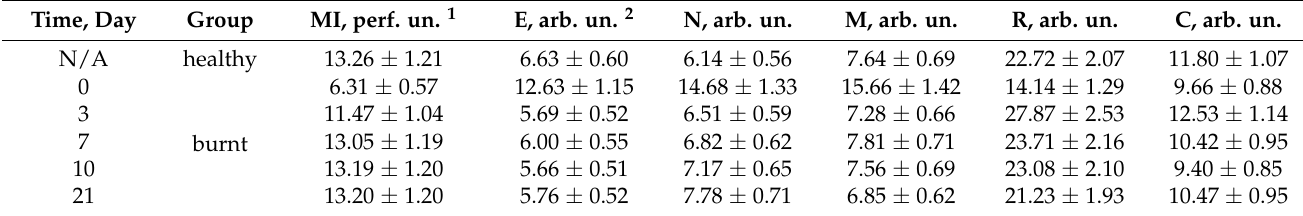
Table 10. Results of Doppler flowmetry of blood microcirculation in a burn wound under the action of control oleogel ( p < 0.001). Time, Day Group MI, perf. un.